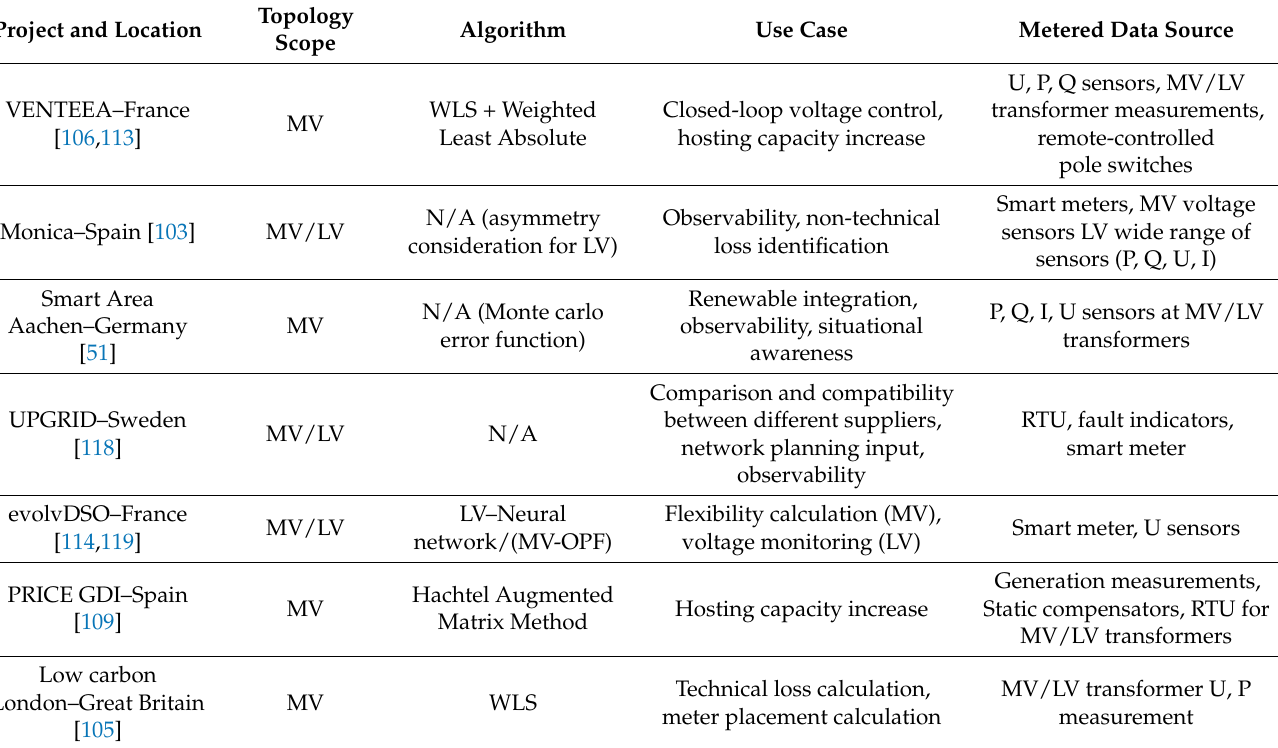
Table 3. Summary of the main attributes from pilot